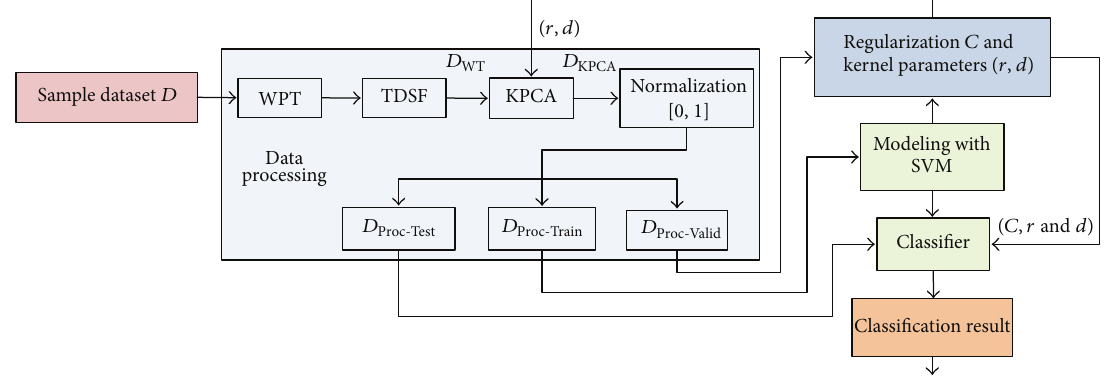
Figure 1: The flowchart of the proposed